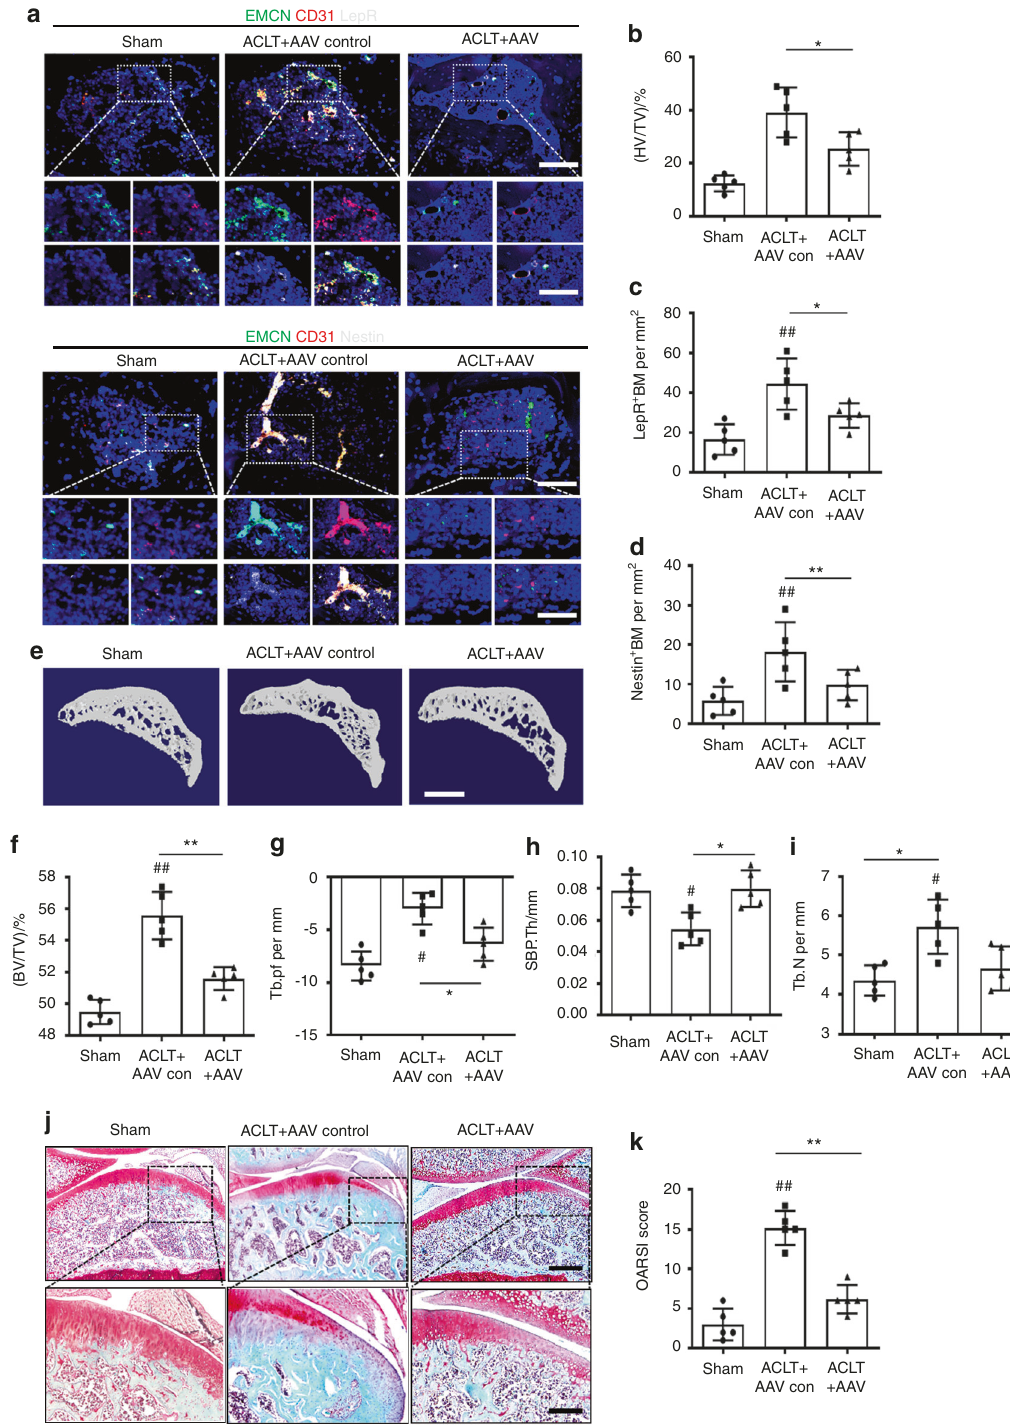
Fig. 7 Speci fi c inhibition of PDGFR- β in ECs attenuates OA development. a Confocal images (upper) with the magni fi ed area (bottom) in the boxed area in the upper image of H-type vessels (merge: yellow; endomucin: green; CD31: red) and LepR + cells (left part, white) and Nestin + cells (right part, white) in the subchondral bone from the sham, ACLT + AAV control and ACLT + AAV rats at 8 weeks post-ACLT. Scale bar, bottom 50 µm; top 100 µm. Quanti fi cation of subchondral H-type vessel volume ( b ) and LepR + cells ( c ) and Nestin + cells ( d ) from the sham, ACLT + AAV control and ACLT + AAV rats at 8 weeks post-ACLT. n = 5. μ CT images of medial subchondral bone ( e ) and quantitative analysis of BV/TV ( f ), Tb.pf ( g ), SBP.Th ( h ), and Tb.N ( i ) from the sham, ACLT + AAV control and ACLT + AAV rats at 8 weeks post-ACLT. n = 5. Scale bar, 500 µm. ( j ) SOFG (upper) with the magni fi ed area (bottom) in the boxed area in the upper image of articular cartilage from the sham, ACLT + AAV control, and ACLT + AAV rats at 8 weeks post-ACLT; proteoglycan (red) and bone (green). Scale bar, bottom 50 µm; top 100 µm. k OARSI-modi fi ed Mankin scores of articular cartilage in sham, ACLT + AAV control, and ACLT + AAV rats at 8 weeks post-ACLT. n = 5. Sham = sham controls; ACLT + AAV control = AAV control-treated ACLT rats; ACLT + AAV = AAV for silencing endothelial PDGFR- β -treated ACLT rats; * P < 0.05 and ** P < 0.01 compared to the ACLT + AAV control group. # P < 0.05 and ## P < 0.01 compared to the sham